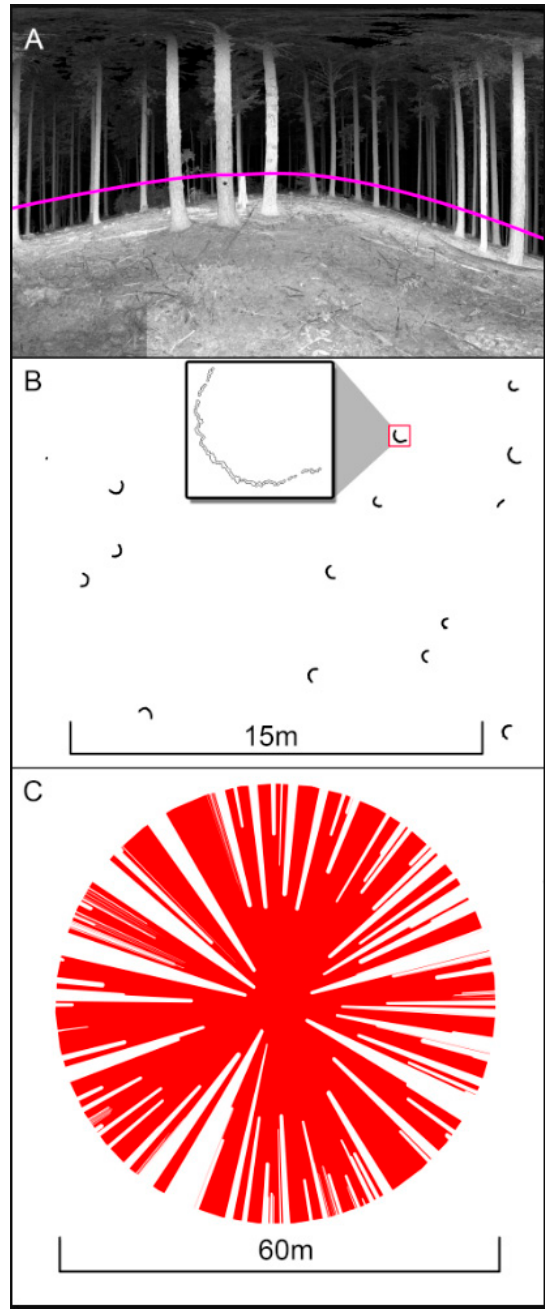
Figure 4. Illustration of the processes used to create isovist polygons at each plot: ( A ) Digitization of a polyline on the panoramic pointcloud at 1.4 m above the ground; ( B ) Planar view of the extracted cross section. This is followed by creating buffers around each point; ( C ) Generate visibility polygon (isovist) to calculate percent occlusion and potentially identify tree locations and DBH.